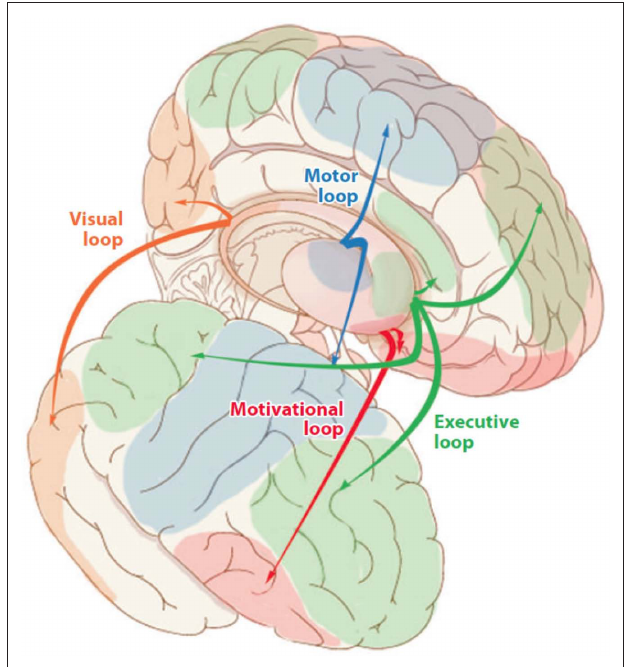
Figure 1 | The fractionation of long-term memory proposed by Squire and Zola-Morgan. Redrawn based on Squire and Zola-Morgan (1991). Figure 2 | Corticostriatal